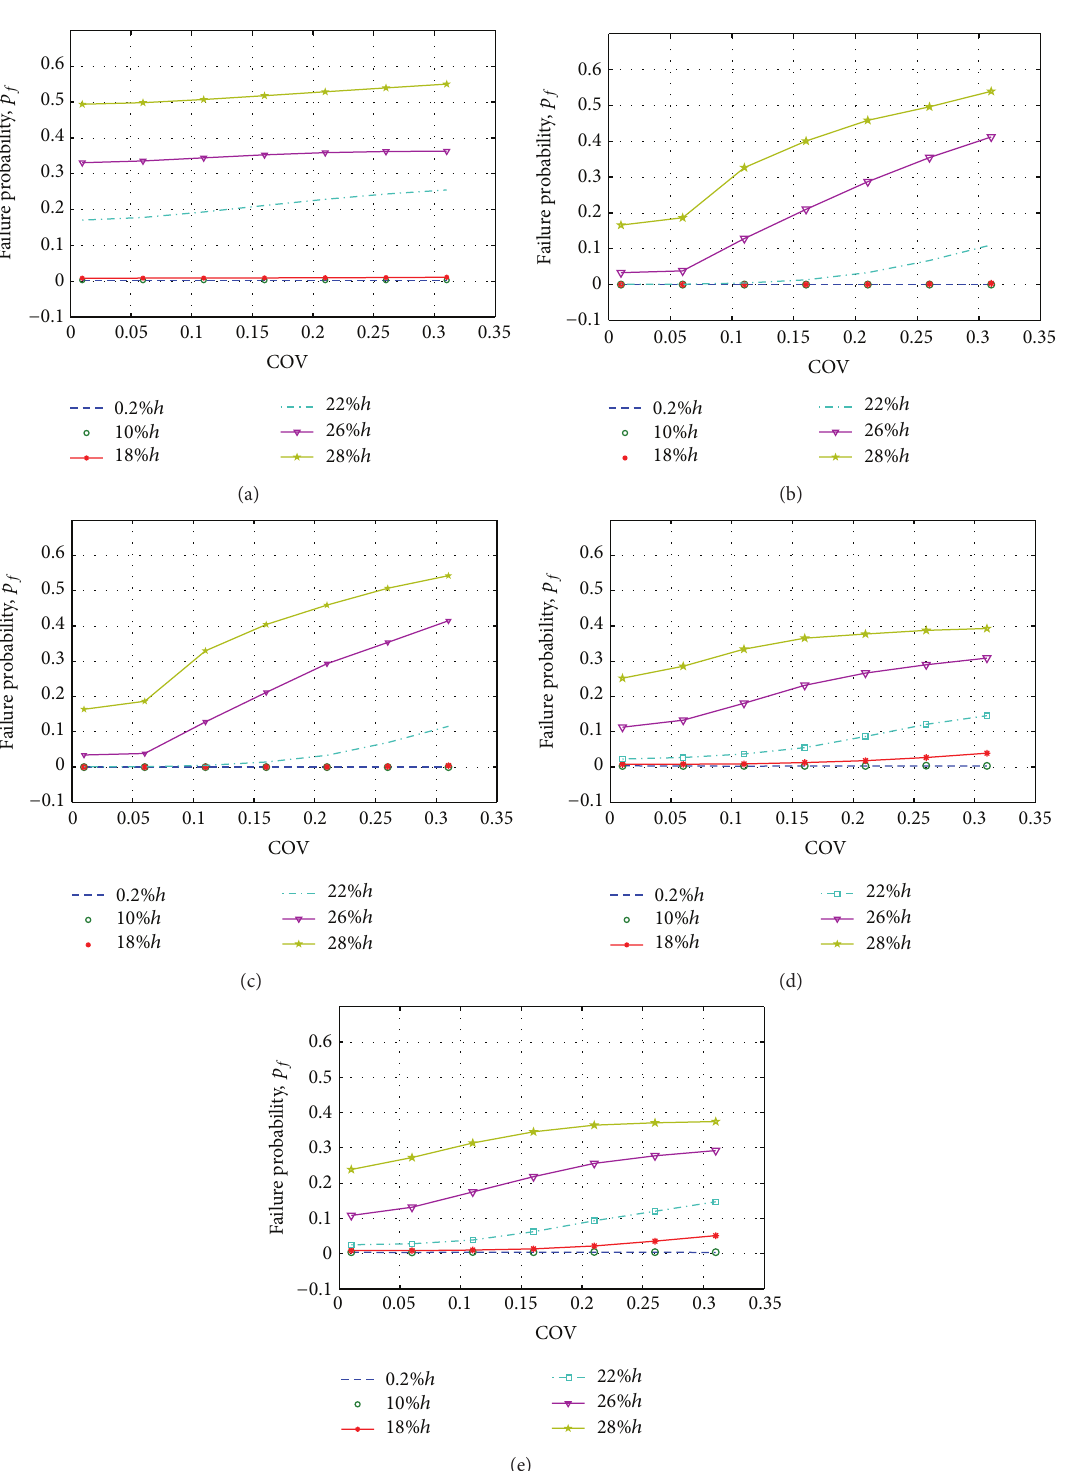
Figure 11: Failure probability by (a) FORM, (b) FORM with RSM first-order, (c) MC with RSM first-order, (d) MC with RSM second-order, and (e)